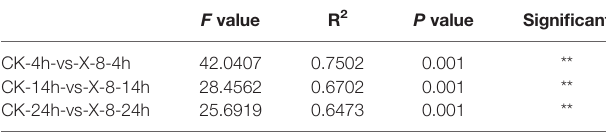
TABLE 3 | Pairwise comparison using permutational multivariate analysis of variance (PERMANOVA) with adonis based on Bray – Curtis. F value R 2 P